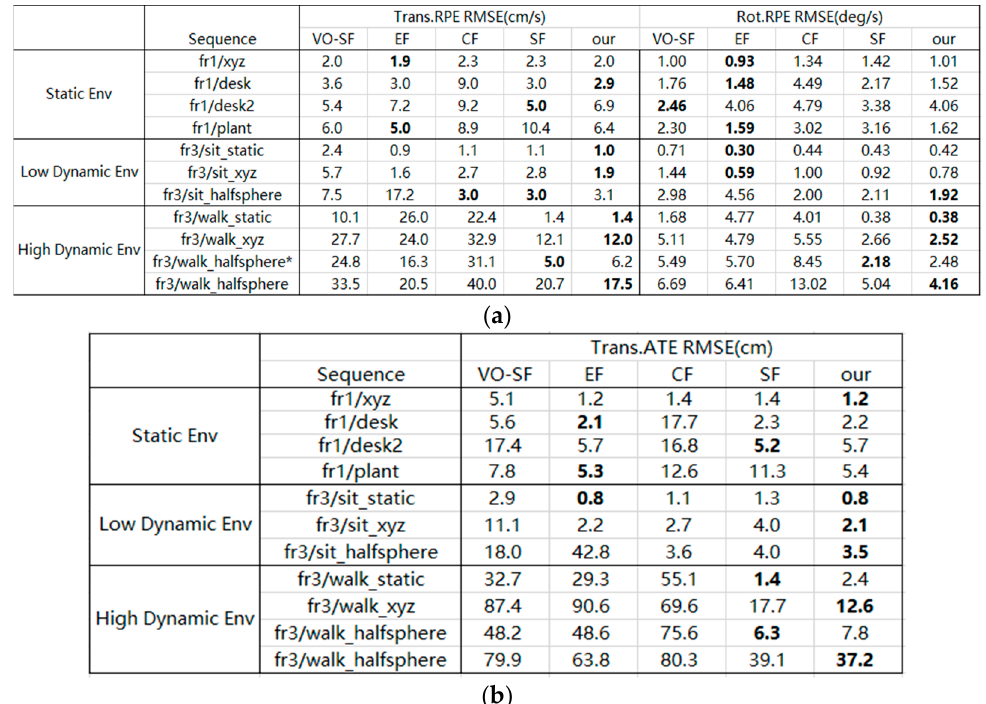
Figure 7. Quantitative comparison of camera pose estimation between the proposed method and other methods. ( a ) Relative pose error. ( b ) Absolute trajectory error.